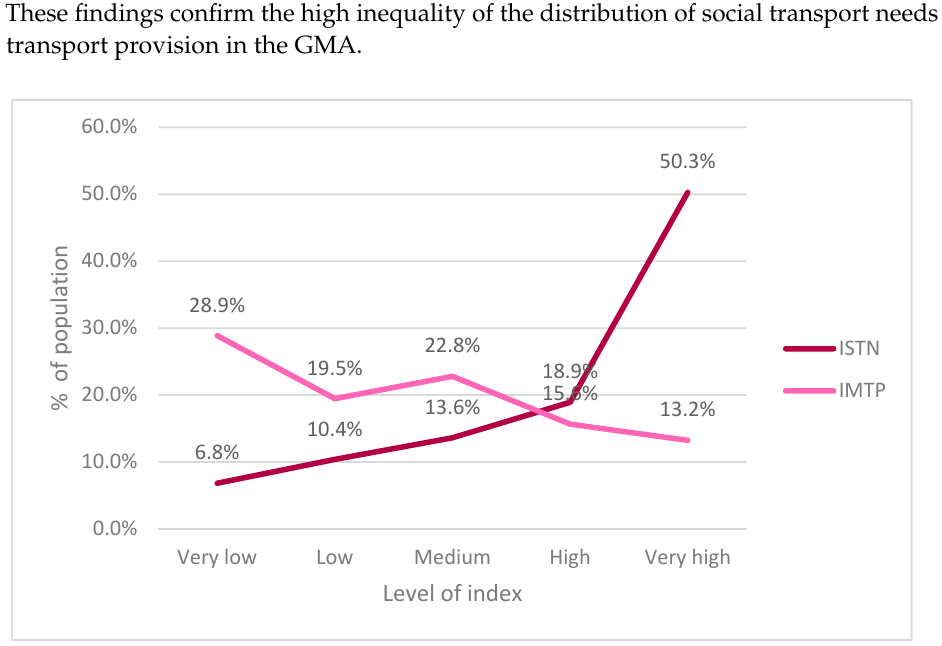
Figure 7. Distribution of the Levels of MTP and of STN in the 1834 GS Source: Authors.